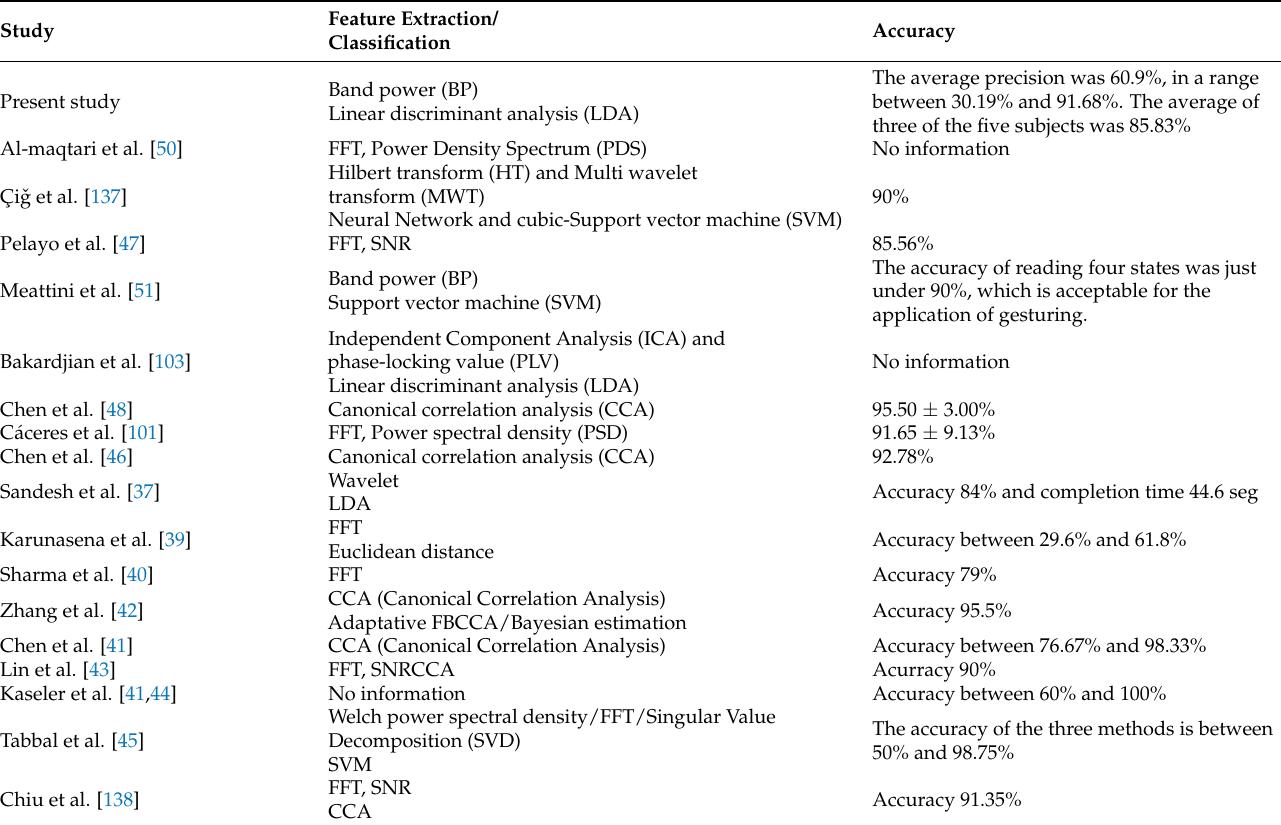
Table 10. Signal processing